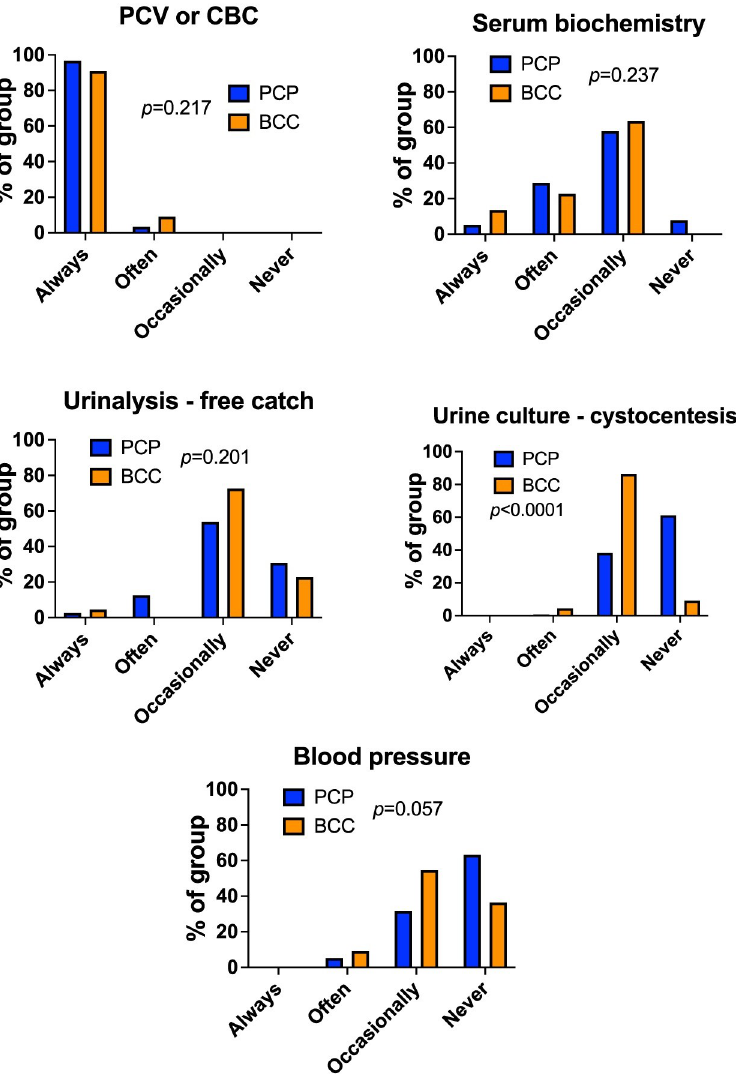
Fig 9. Board-certified clinicians obtain more urine samples by cystocentesis during follow-up visits. Bar graphs showing percentage of respondents performing indicated tests at indicated frequencies according to group during follow-up visits for dogs being treated for IMHA. PCP: primary care practitioner, n = 152. BCC: board-certified clinician, n = 22. Chi-squared or Fisher’s exact